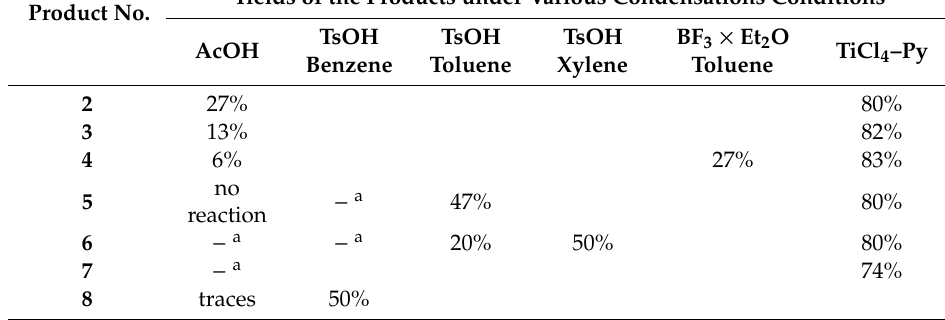
Table 1. Yields of the diimines 2 – 8 in the condensation of dipinodiazafluorenone 1 with diamines under various reaction